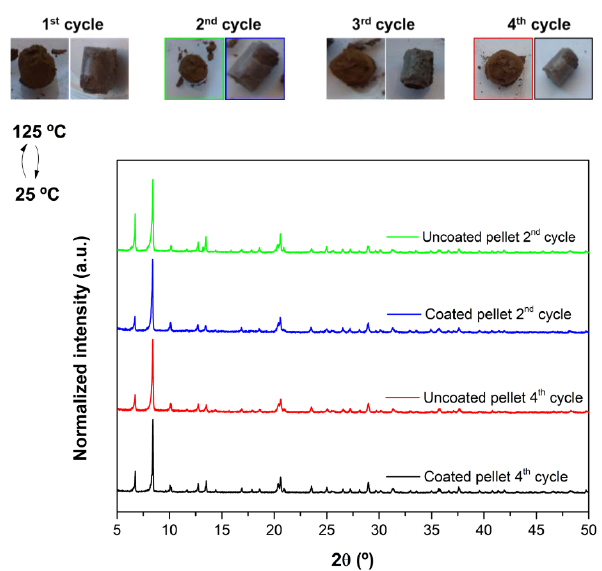
Figure 4. Powder X-ray diffractograms of the studied materials, as-synthesized and after processing into pellets.